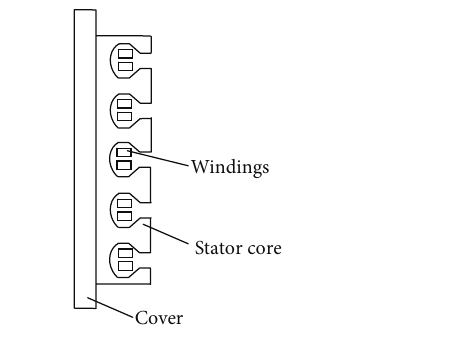
Figure 2: Power spectral density of electromagnetic forces used analytical methods.